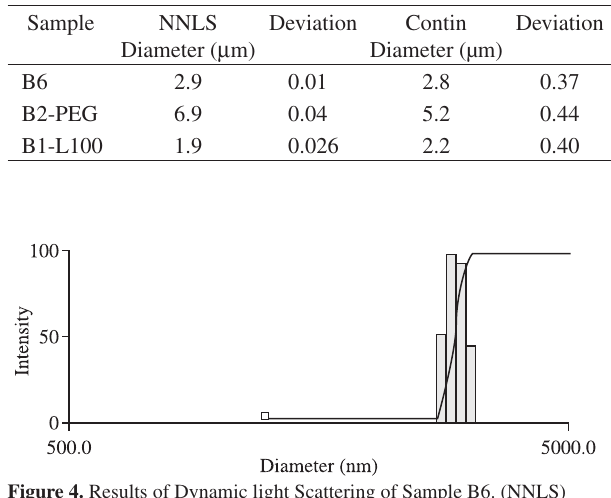
Table 3. Results obtained by Dynamic Light Scattering.